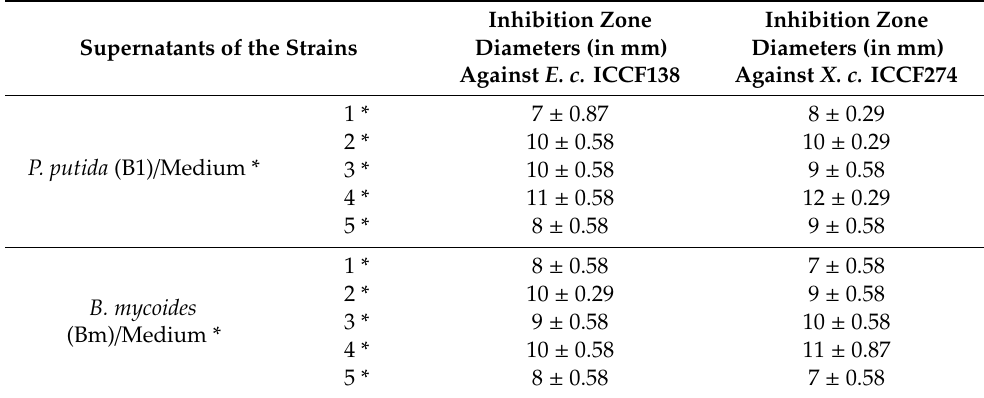
Table 2. Antimicrobial activity (as zones of inhibition) of the biosurfactants after 48 h of growth together with the